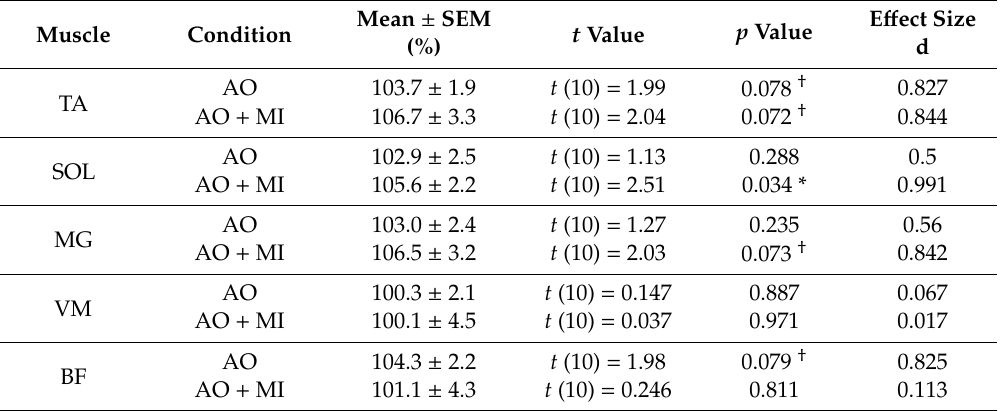
Table 1. Summary of the statistical analysis (one-sample t -test) comparing transcutaneous spinal cord stimulation (tSCS)-evoked reflexes between action observation (AO) with or without motor imagery (MI) and control conditions Mean ± SEM E ff ect Size t Value p Value Muscle Condition (%) d AO 103.7 ± 1.9 t (10) = 1.99 0.078 † 0.827 TA AO + MI 106.7 ± 3.3 t (10) = 2.04 0.072 † 0.844 AO 102.9 ± 2.5 t (10) = 1.13 0.288 SOL 105.6 ± 2.2 AO + MI 106.5 ± 3.2 t (10) = 2.03 0.073 † 0.842 AO 100.3 ± 2.1 t (10) = 0.147 0.887 0.067 VM AO + MI 100.1 ± 4.5 t (10) = 0.037 0.971 AO 104.3 ±